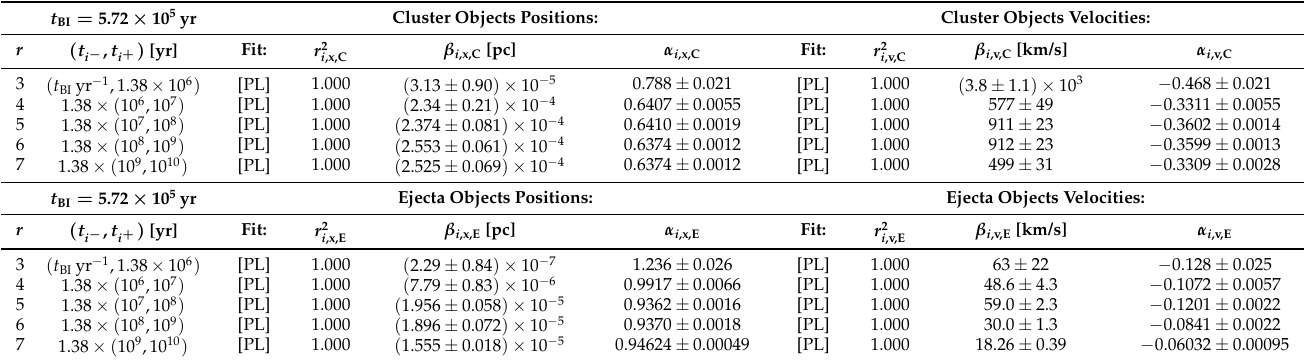
Table 4. Mean cluster and ejecta position and velocity PL fits of Figure 7 from Equation (31): z P ( t ∈ r ) = β i , z ,P t α i , z ,P , where z = x , v and r = 3, . . . ,7 refers to the separate run where the fit is performed, β i , z ,P corresponds to the amplitude of the PL, α i , z ,P is the PL index and P = C,E denotes the cluster and ejecta populations, respectively. t BI = 5.72 × 10 5